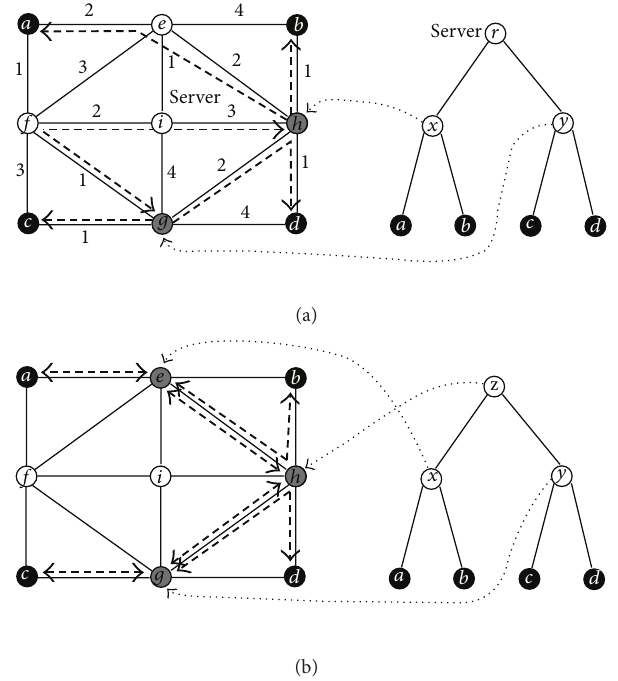
Figure 1: Ignore the dashed lines on the left top subfigure to obtain a sample graph where the number on each edge represents its length. The right top subfigure is a sample rooted TeST and the right bottom is a sample unrooted TeST. An example centralized many-to-many multicast tree under a fixed topology is distinguished by dashed lines on the left top subfigure and an example decentralized one is distinguished on the left bottom